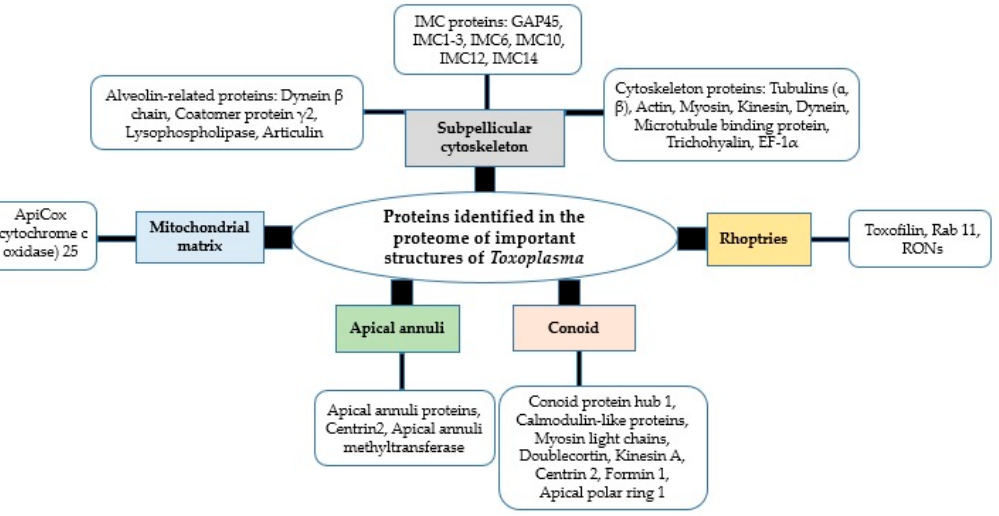
Figure 3. Proteins identified in the proteome of important structures of the Toxoplasma parasite. The dynamic adhesion, invasion, and even replication properties of Toxoplasma are based on machinery located in the pellicle. A group of glycosylphosphatidylinositol (GPI)-linked proteins (SRSs) were identified as important proteins in Toxoplasma -pellicle proteome [156]. Toxoplasma SRS13 and SRS29A have shown strong immunogenicity but have not been evaluated in the development of a vaccine model or diagnostic assay yet